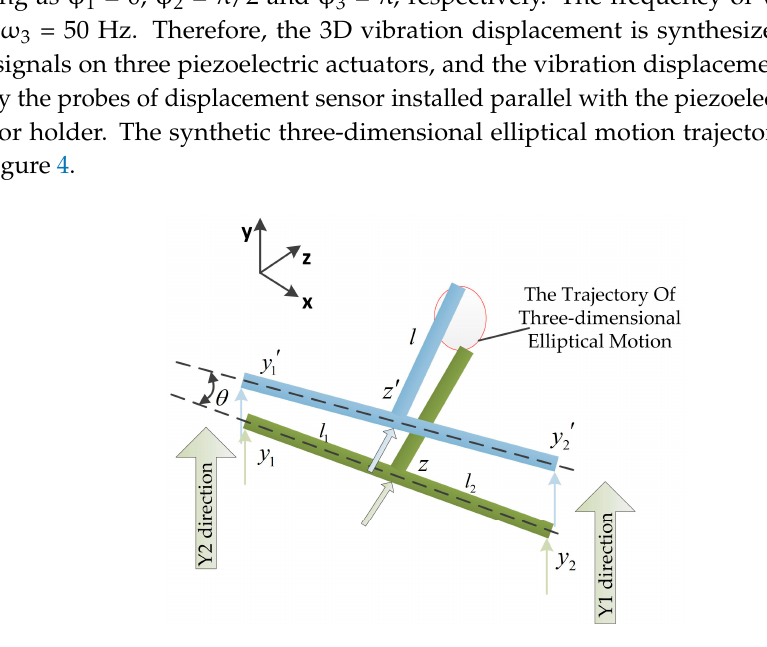
Figure 3. The generation principle of three-dimensional elliptical motion in the tool tip.